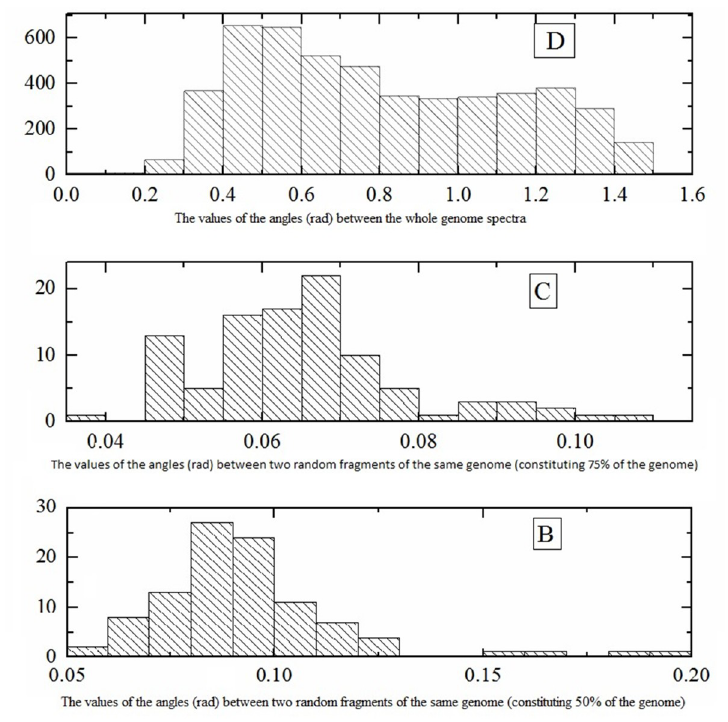
Fig 2. Distribution of pairwise angles between the BS spectra of complete genomes and between the BS spectra of the same genome fragments. (D) All pairs of complete genomes from library L. (C), (B) All pairs of the same genome fragments for all genomes from library L; the fragment sizes are equal to 75% (C) and to 50% (B) of the corresponding total genome. X axis: angles in radians.